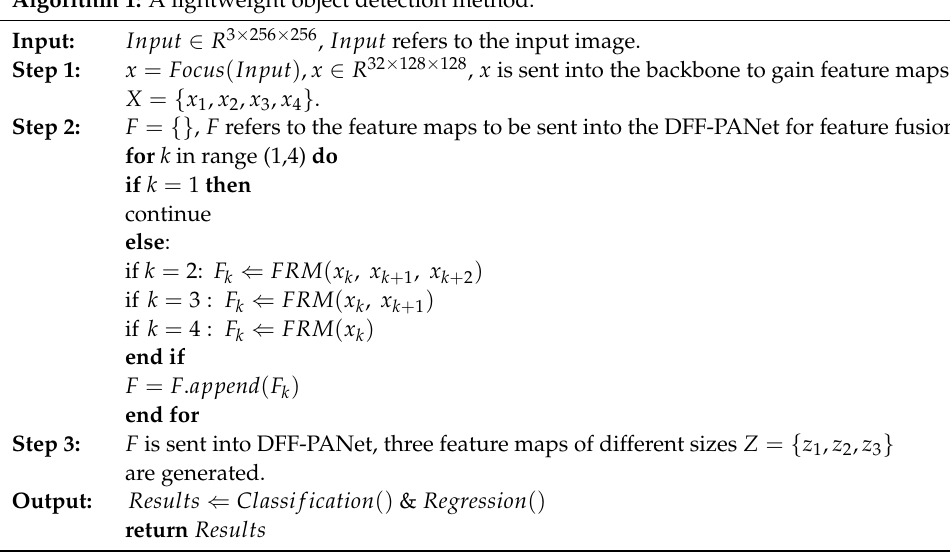
Algorithm 1: A lightweight object detection